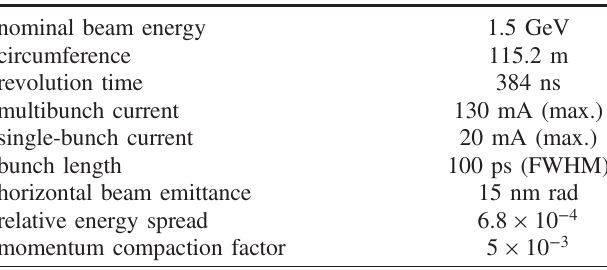
TABLE II. Parameters of the electron storage ring